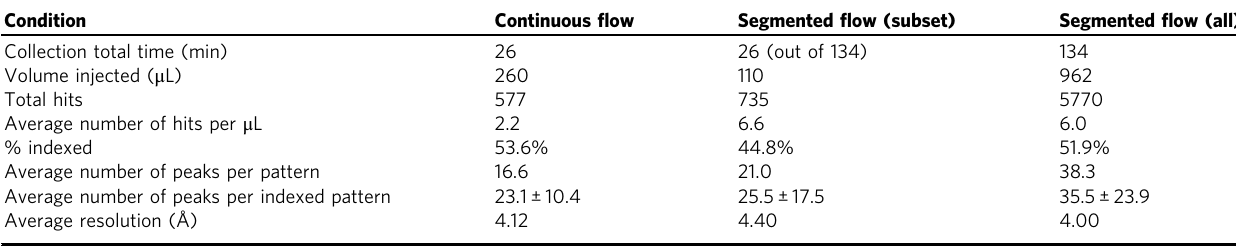
Table 1 Comparison between continuous and segmented fl ow